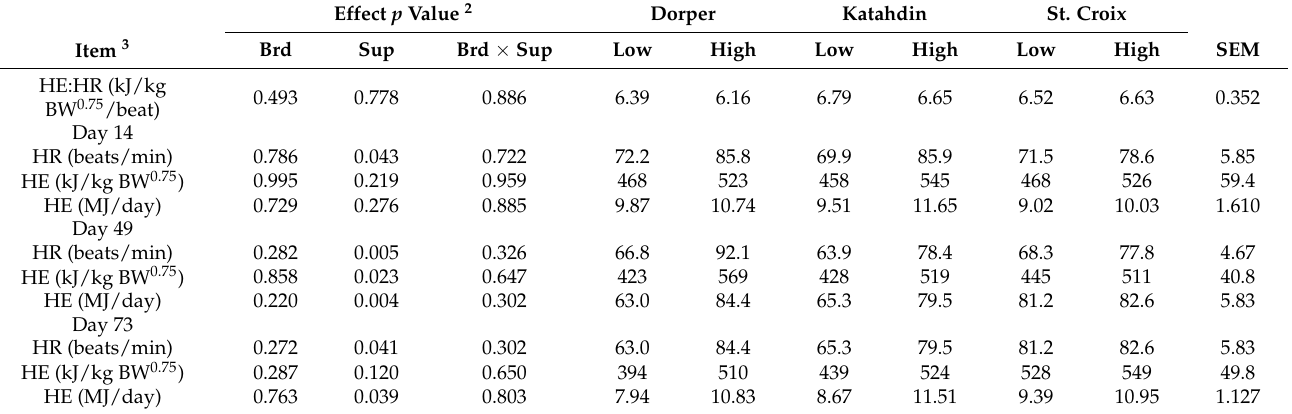
Table 6. Effects of breed and supplement treatment on heart rate and heat energy by hair sheep 1 . Effect p Value 2 Dorper Katahdin